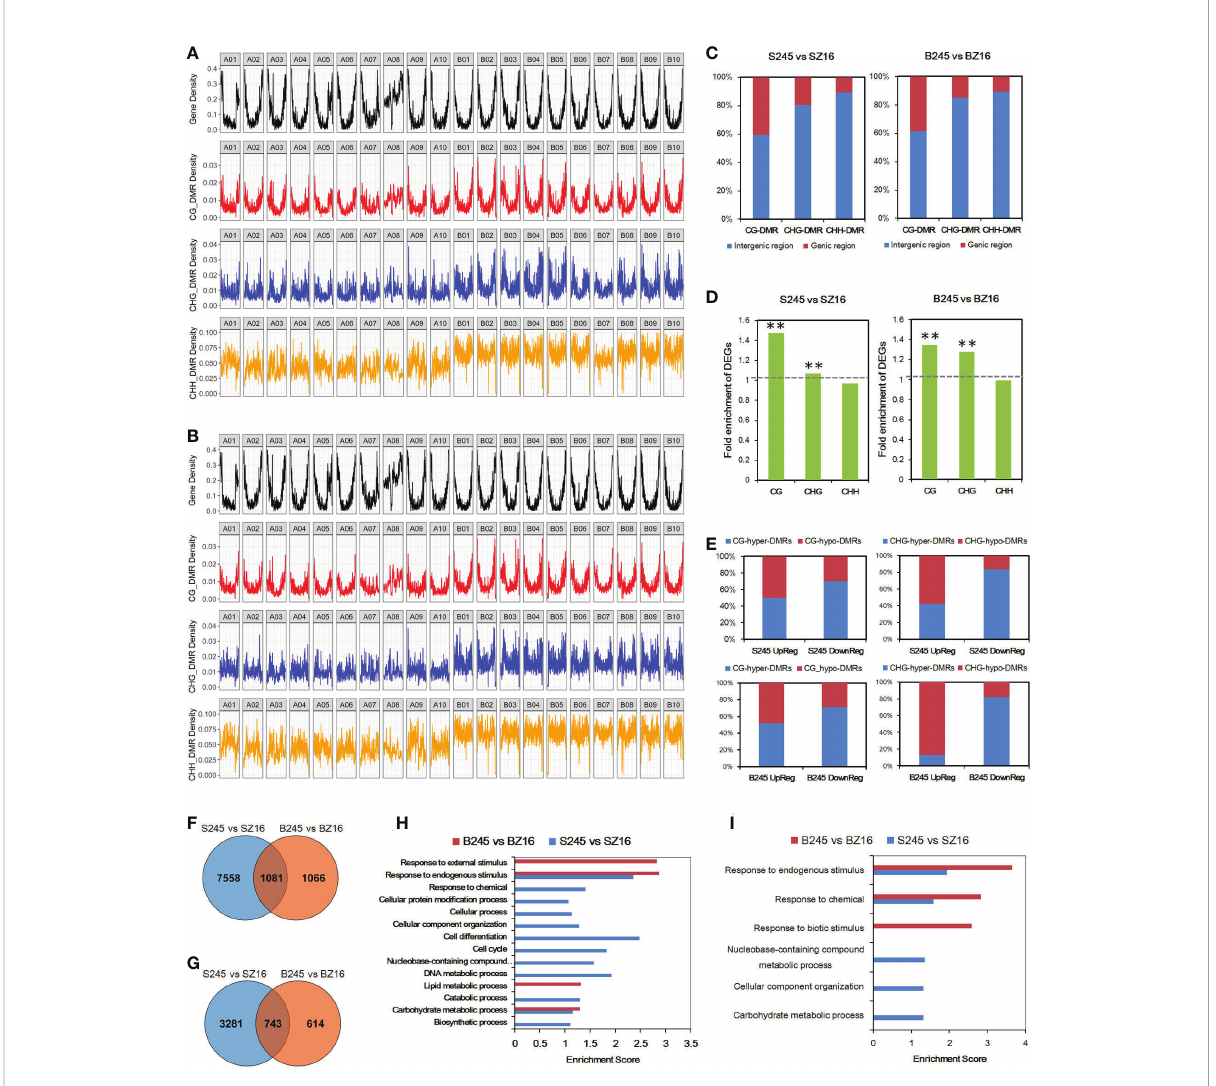
FIGURE 6 In fl uence of DMR on differential gene expression. (A, B) Genome-wide distribution of protein-coding genes and DMRs (CG, CHG, and CHH) between wild and cultivated seeds at the R5 stage (A) and R8 stage (B) . (C) Percentage of DMRs in the genic region and intergenic region. (D) Fold enrichment of DEGs in those overlapping with DMRs in the gene body with 2 kb upstream. The hypergeometric test was used to infer statistical signi fi cance (** P < 0.01). (E) The ratio of (hyper/hypo) DMRs in CG or CHG contexts overlapped with DEGs (up/down) between seeds of 245 and Z16 at the R5 and R8 stages. (F) Venn diagram of CG-DMR-associated DEGs at the R5 and R8 stages. (G) Venn diagram of CHG-DMR-associated DEGs between 245 and Z16 at the R5 and R8 stages. (H) GO enrichment analysis of CG-DMR-associated DEGs between 245 and Z16 at the R5 and R8 stages. GO terms with P -value <0.05 were listed in the y-axis. (I) GO enrichment analysis of CHG-DMR-associated DEGs between 245 and Z16 at the R5 and R8 stages. GO terms with P -value <0.05 were listed in the y-axis. S245 and SZ16 denoted seeds of 245 and Z16 at the R5 stage, respectively. B245 and BZ16 denoted seeds of 245 and Z16 at the R8 stage, respectively. DMR indicated differentially methylated